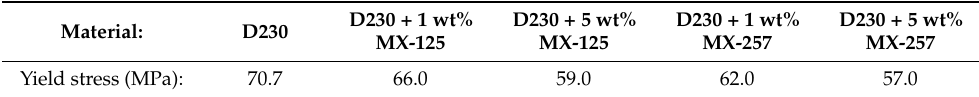
Table 2. Yield stresses of each epoxy resin obtained from experimental uniaxial tensile tests. These values are converted to true stresses, which are required for Abaqus input files.